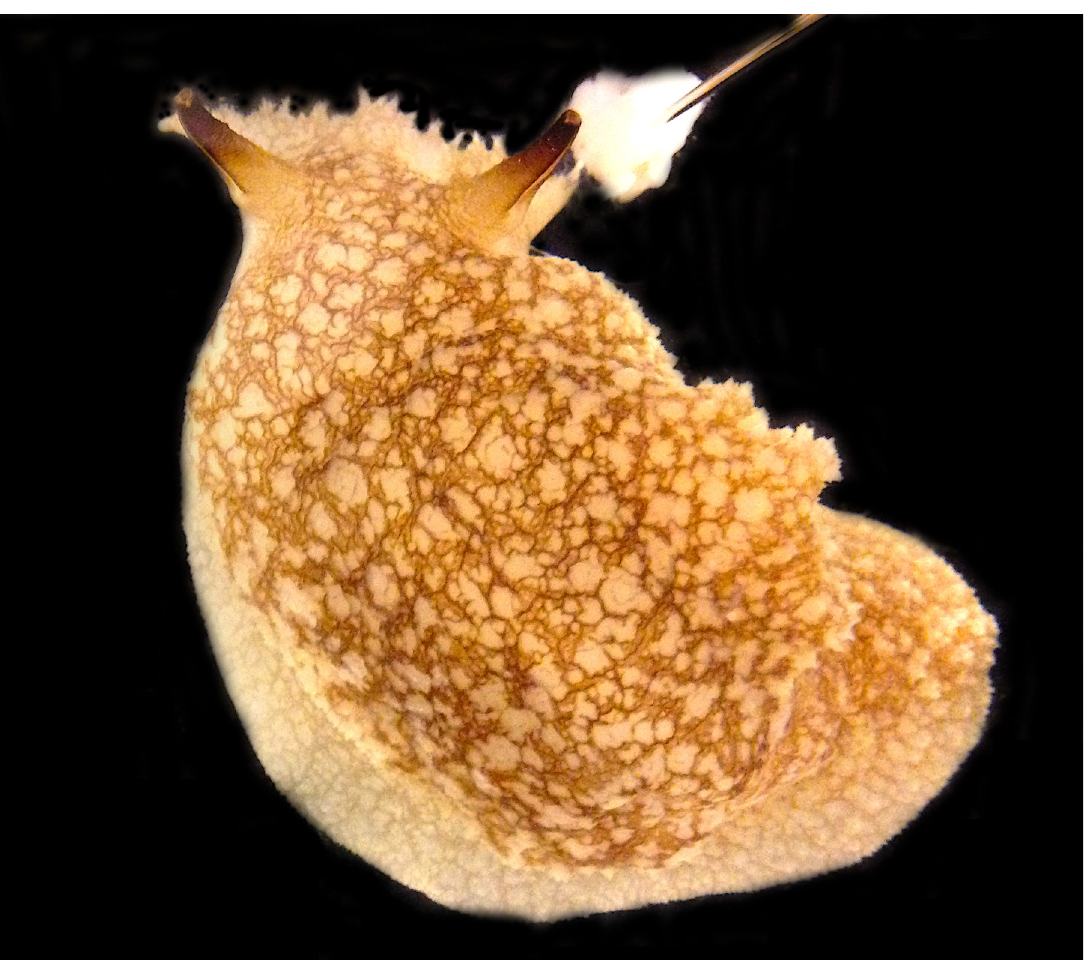
Fig 1. A specimen of Pleurobranchaea californica engaged in the food-localization